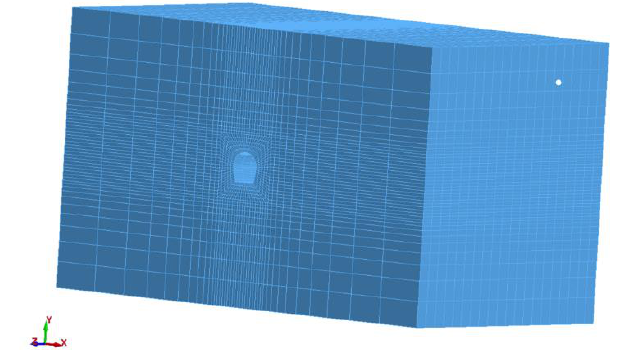
Figure 6. Numerical model. Table 5. Calculation accuracy for different grid sizes. Size of the Grid